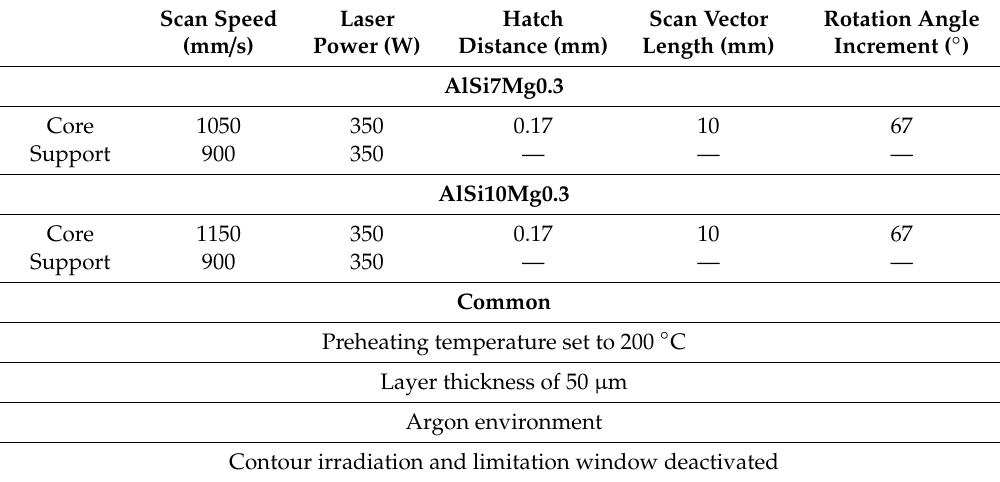
Table 1. Parameter sets utilized for